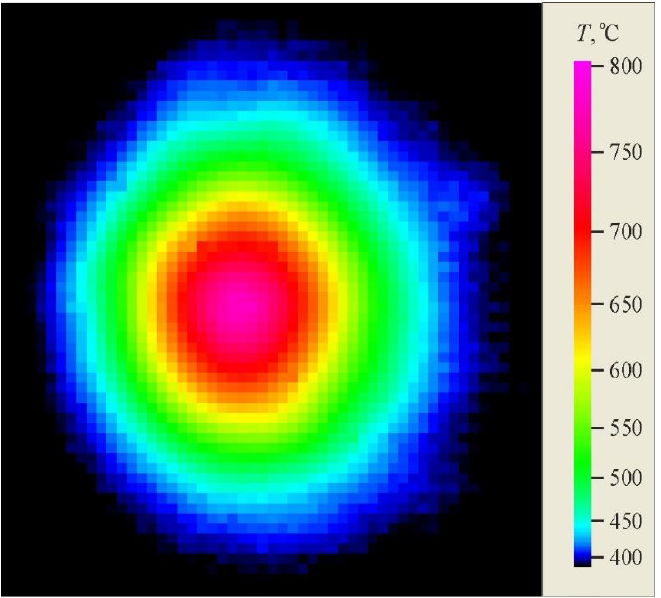
Figure 4. Temperature field along the sample during pulse-periodic laser treatment, exposure time 23 s.